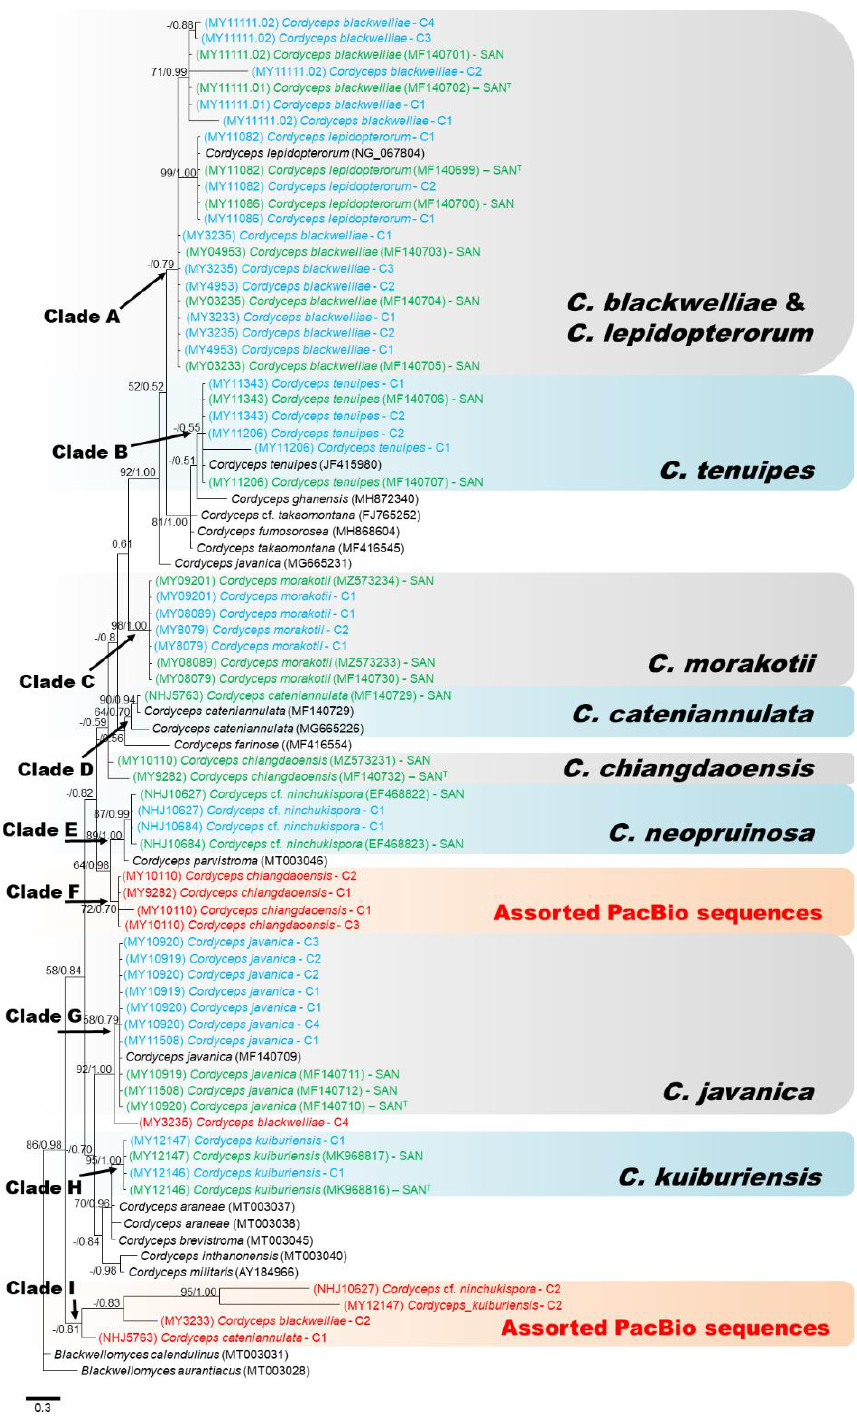
Figure 3. Consensus phylogram (50% majority rule) from a Bayesian analysis of the nrLSU sequences, obtained from 10 6 MCMC generations. Maximum likelihood bootstrap values >50% (left of/) and Bayesian posterior probabilities >0.50 (to the right). The scale bar represents substitution rate per site. The PacBio cluster sequences highlighted in blue are those clustered within corresponding true species clades; other PacBio cluster sequences highlighted in red are those branched outside the species of origin. All Sanger sequences of the studied strains are highlighted in green. Sanger sequences of type species demarked as ‘T’.